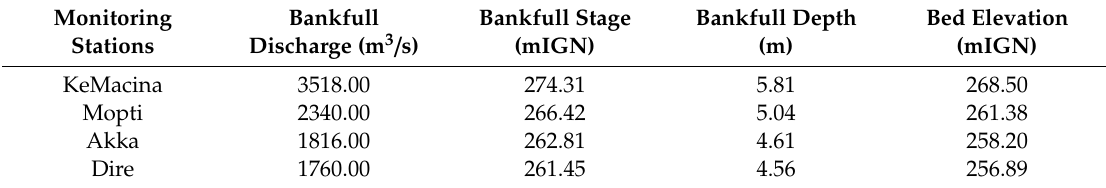
Table 2. Bed elevation of the Niger River at Ke-Macina, Mopti, Akka, and